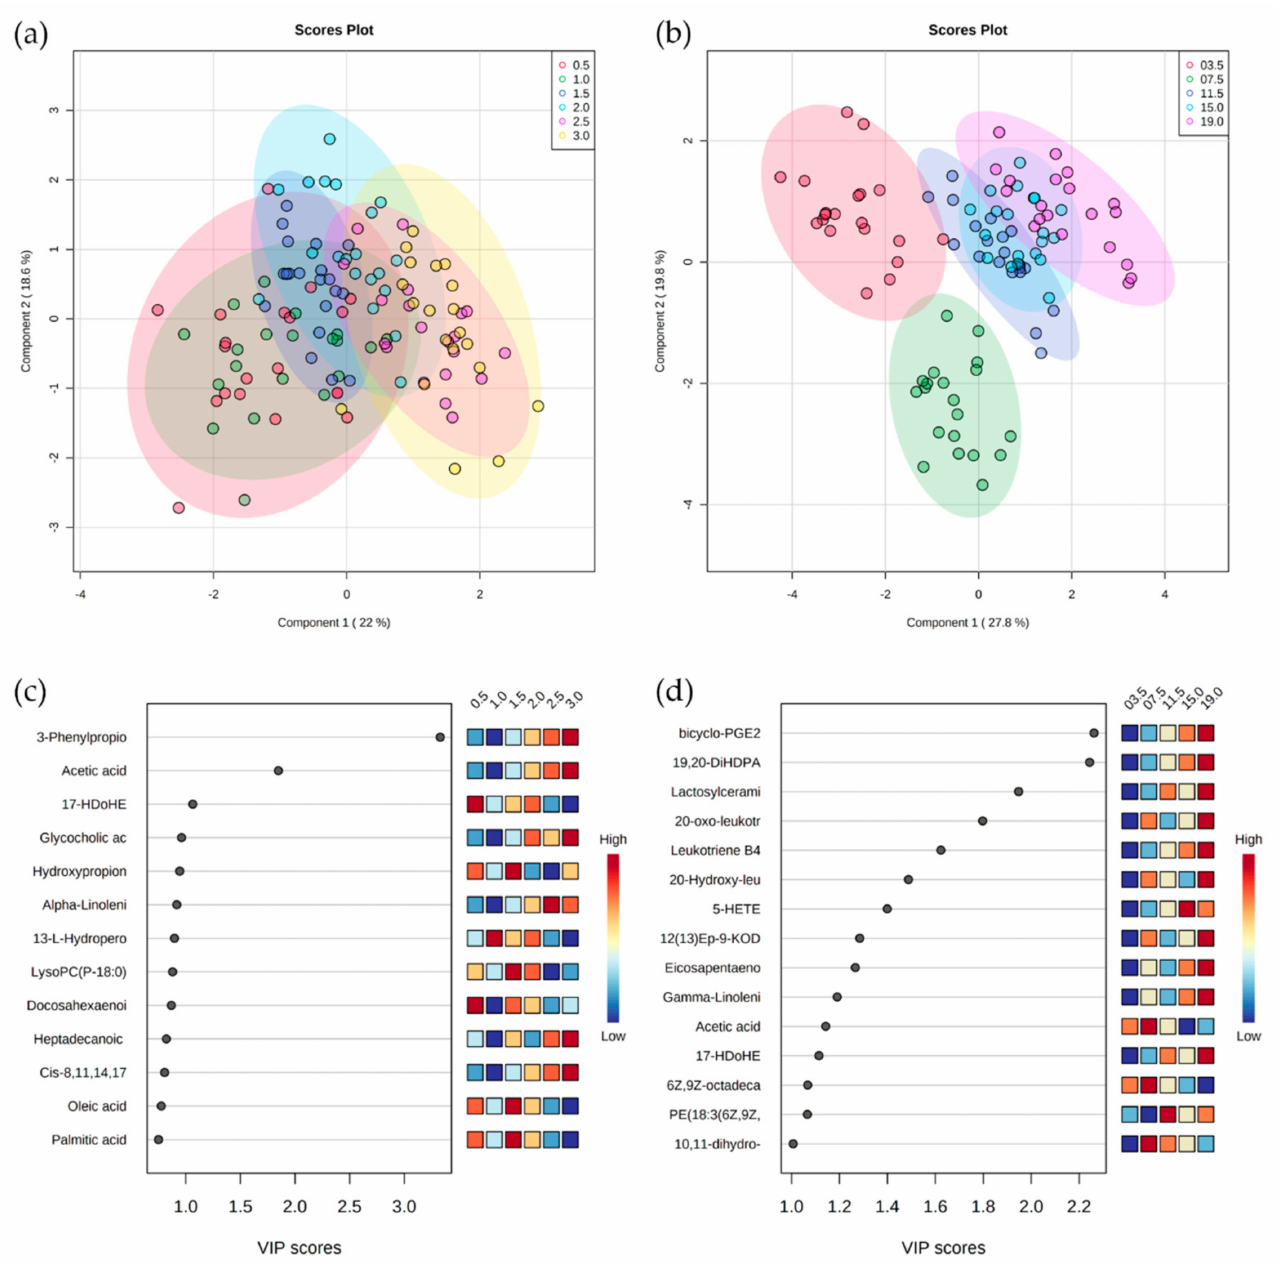
Figure 1. ( a ) PLS − DA of HF heifers between 0.5 and 3.0 months of age. ( b ) PLS − DA of HF heifers between 0.5 and 19.0 months of age. ( c ) VIP score plots produced by PLS − DA of metabolites with a VIP score >0.75 in HF heifers between 0.5 and 3.0 months of age to allow the visualization of metabolites whose values were close to 1. ( d ) VIP score plots produced by PLS − DA of metabolites >1.0 in HF heifers between 0.5 and 3.0 months of age. All in the combined ionization mode m/z